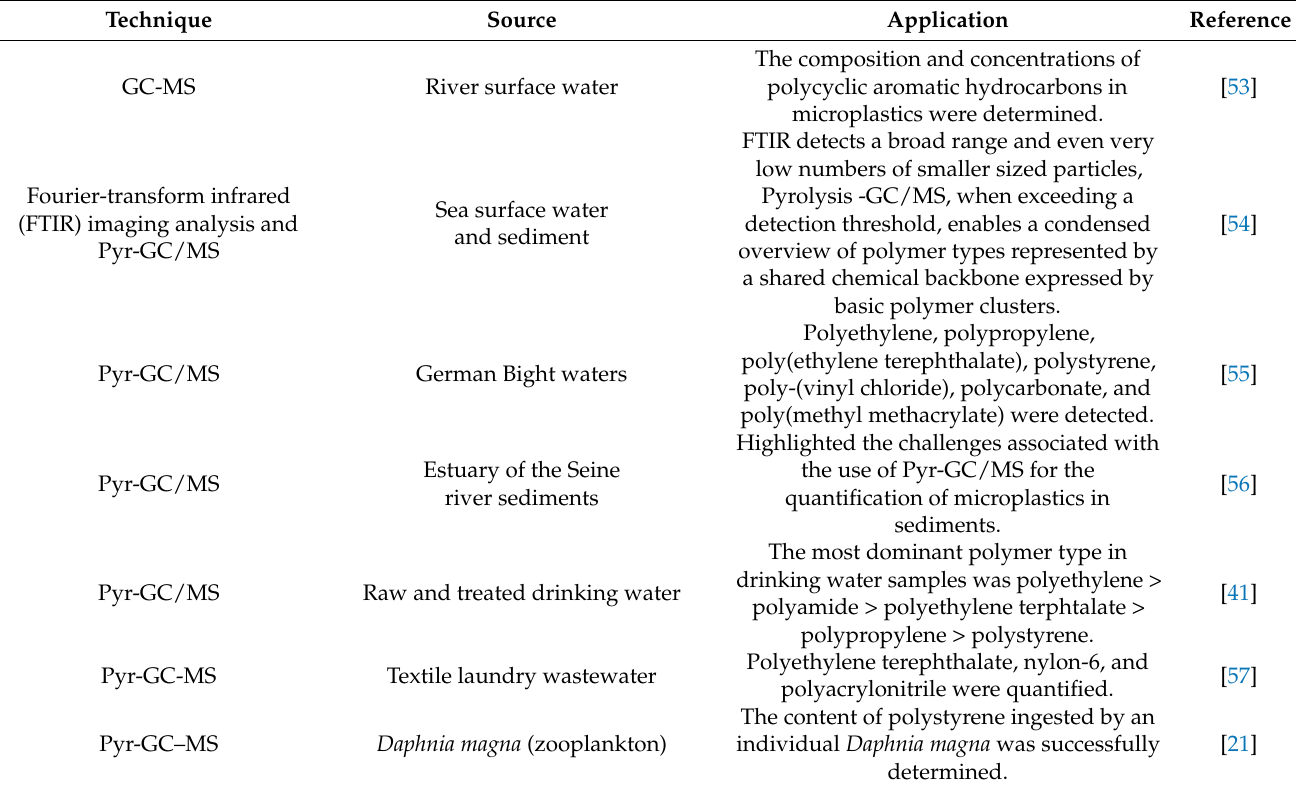
Table 1. GC-MS as microplastic